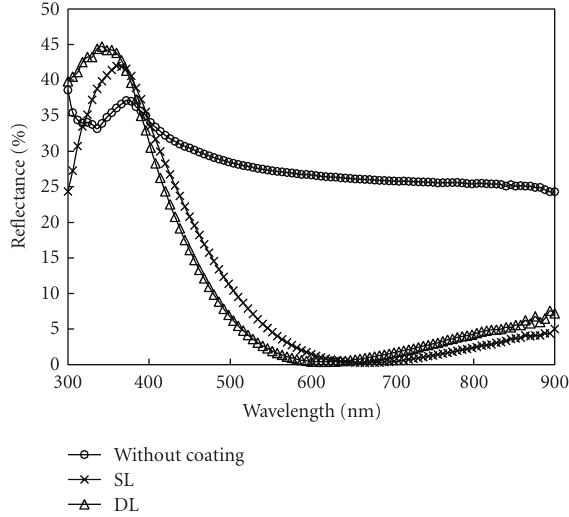
Figure 4: Comparison of reflectance of acid solution textured mc- Si surfaces with (SL, DL) and without Si 3 N 4 coating. One can clearly show that the reflectance for the DL coating is a very low value of 1% between 572nm and 672 nm wavelength.